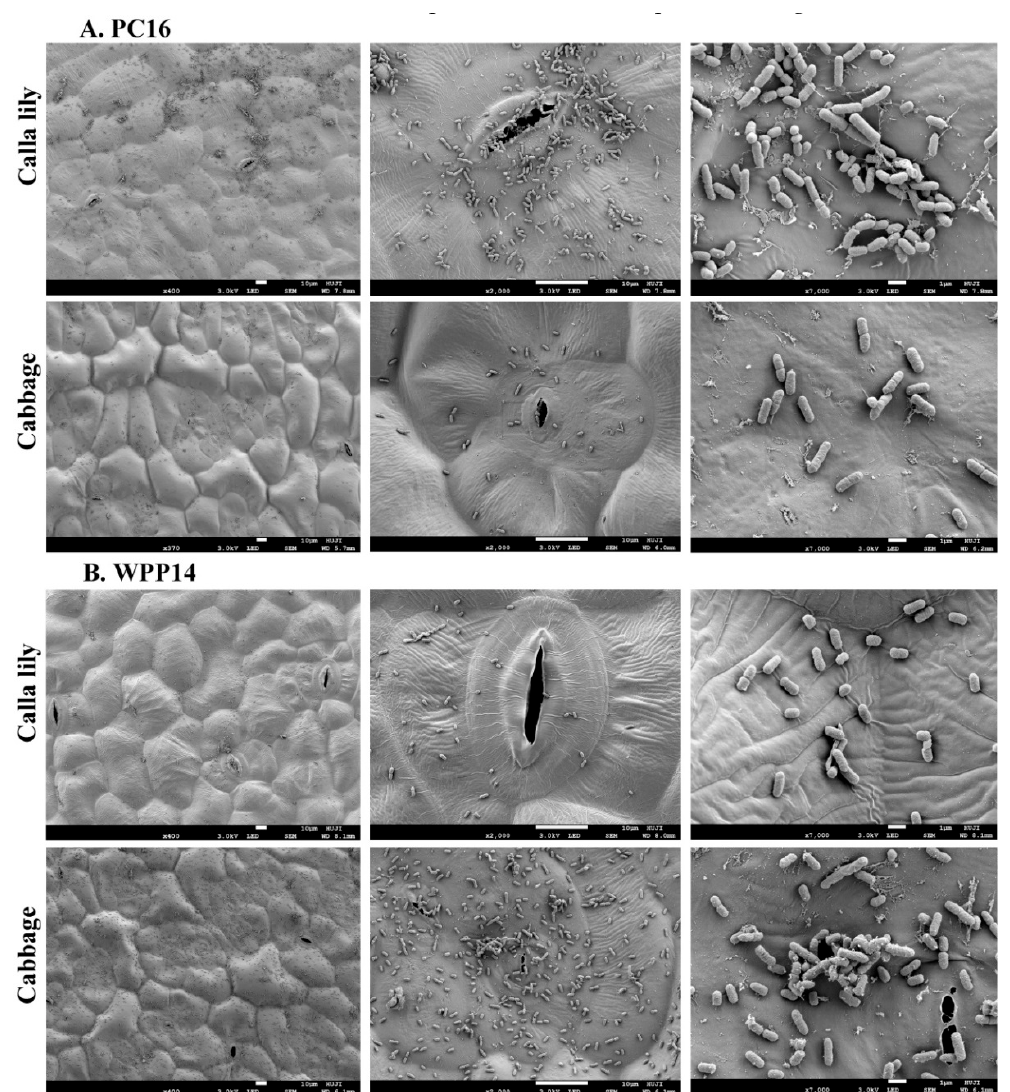
Figure 2. SEM micrographs of ( A ) P. aroidearum PC16 and ( B ) P. carotovorum WPP14 on the leaf surfaces of calla lily and of cabbage. The micrographs were obtained 3 h after inoculation (10 µL, 10 8 cfu/mL) onto the host leaf surfaces. The colonization patterns were examined on 10 leaves for each plant. SEM images are presented (left to right) magnification 400×, bar =50 µm; 2000×, bar = 10 µm; magnification 7000×, bar = 1 µm.